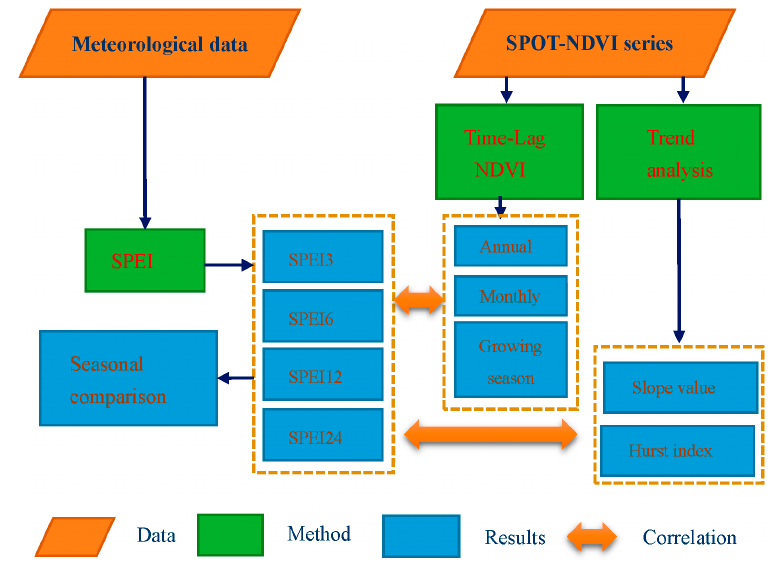
Figure 2. The working flowchart of this study.